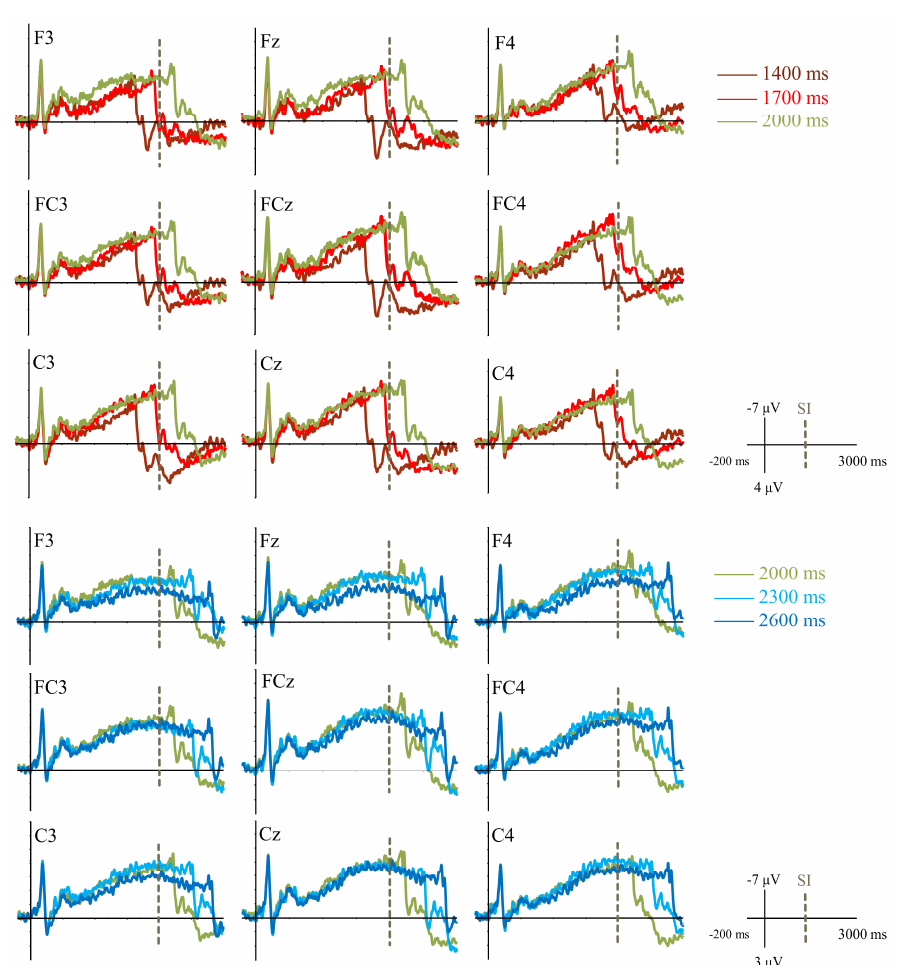
Figure 6. Grand average ERPs induced by different comparison intervals in Experiment 2.